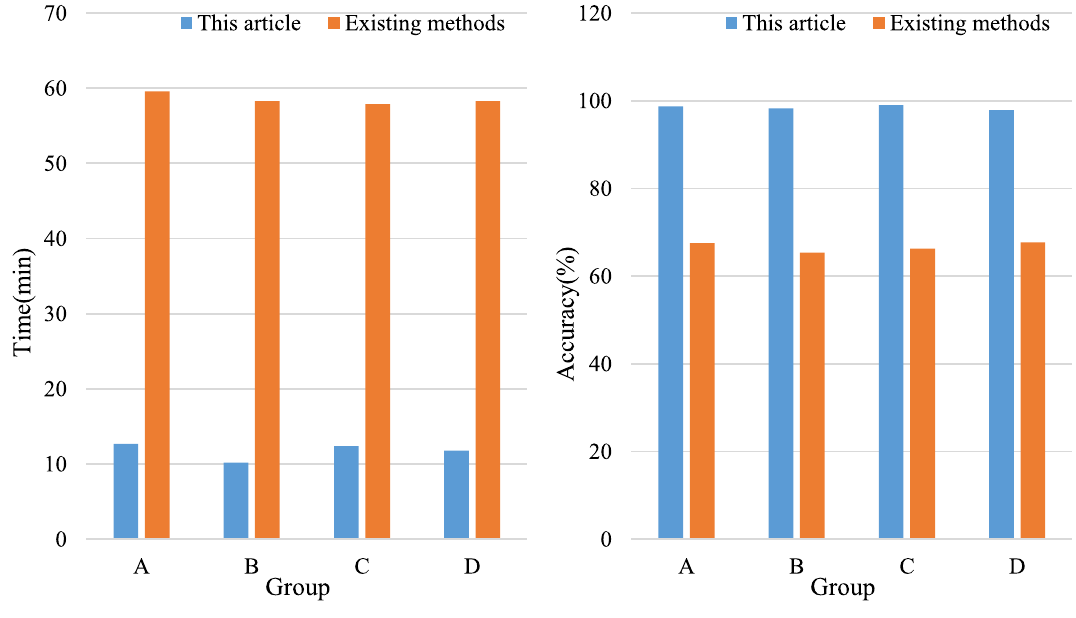
Fig. 9 Comparison of the Rate and Accuracy of Current Data